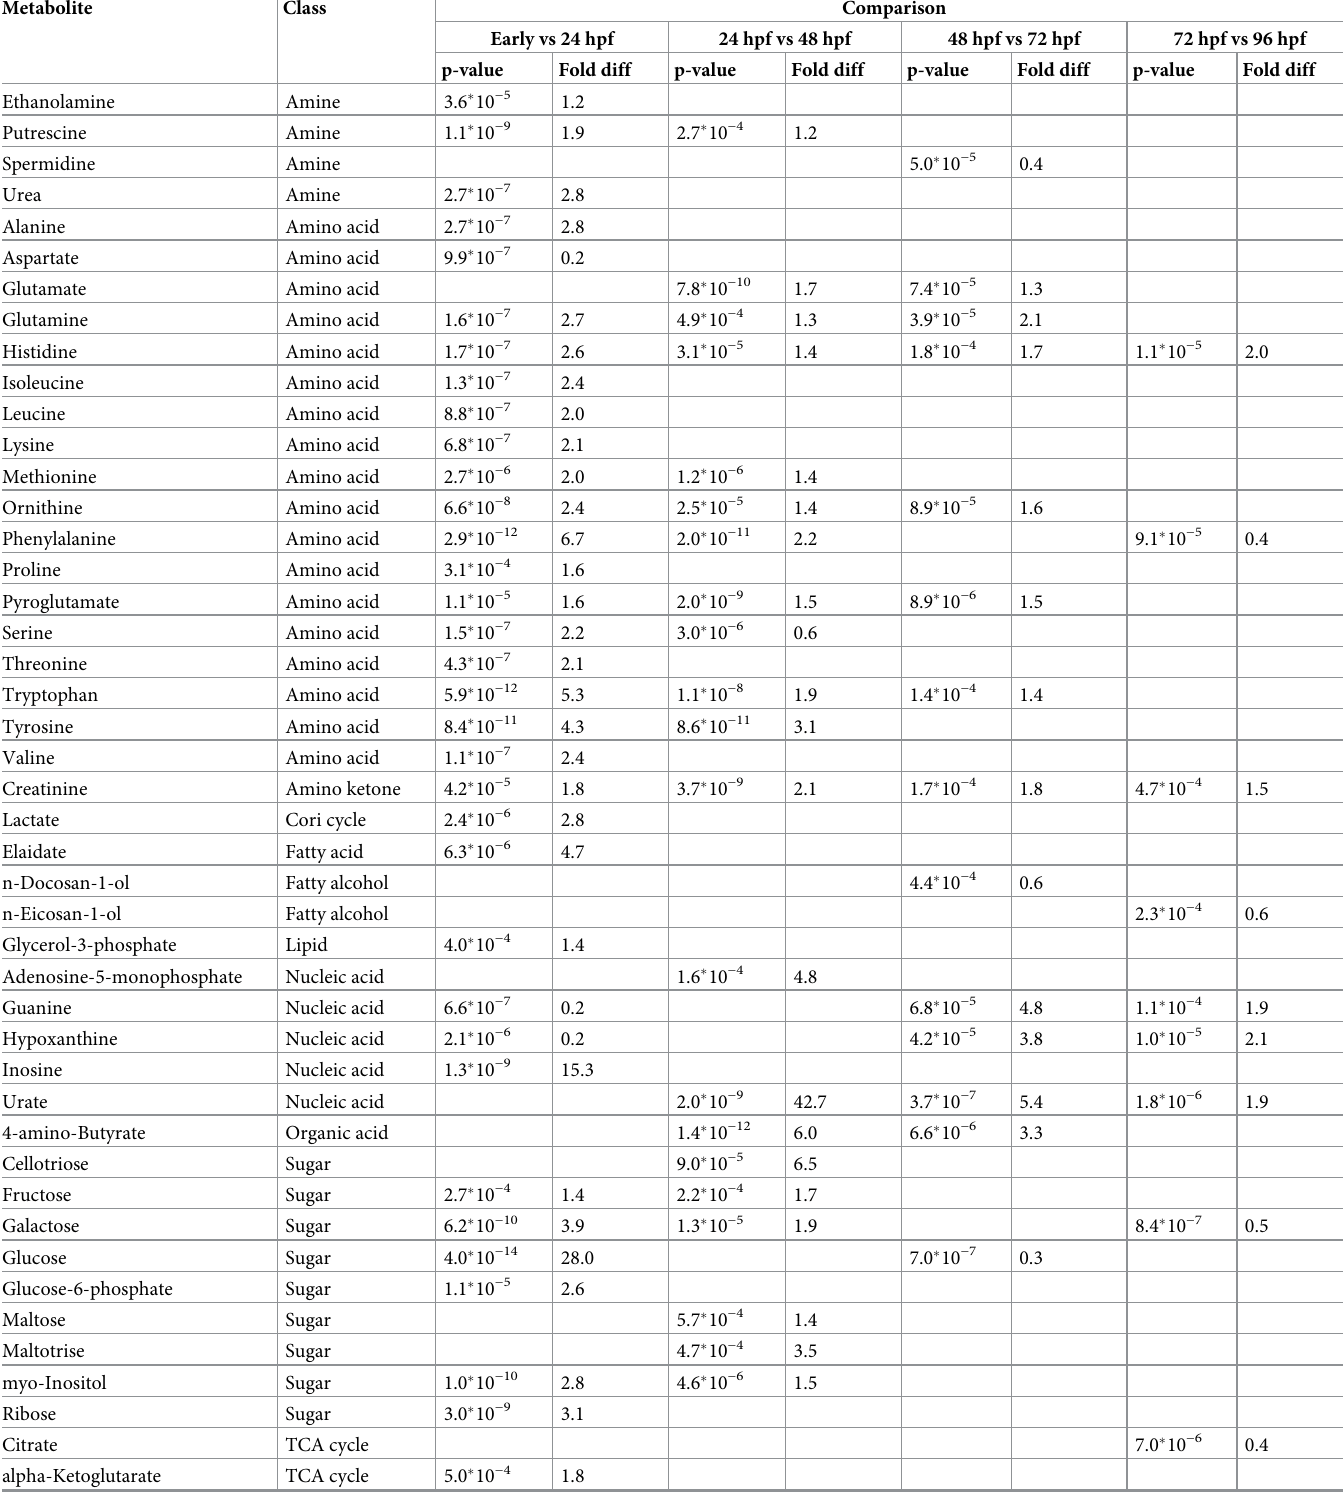
Table 3. Significantly differing metabolites comparing one developmental stage to the